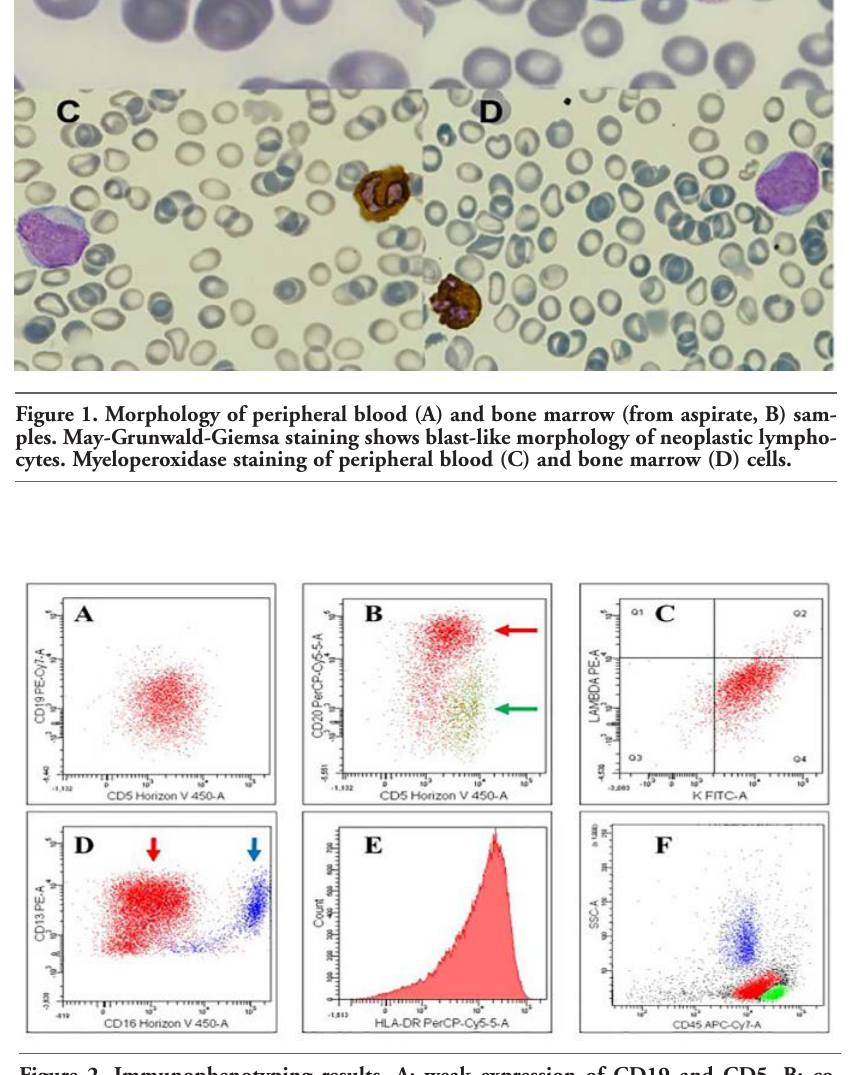
Figure 2. Immunophenotyping results. A: weak expression of CD19 and CD5. B: co- expression of CD20 and CD5 (red dots and red arrow); the green dots and the green arrow show the pattern of CD5 expression by the residual T-lymphocytes. C: restriction for sur- face immunoglobulin K light chains. D: pattern of CD13 expression of neoplastic lym- phocytes (red dots and red arrow) compared with neutrophils (blue dots and blue arrow). E: positivity of HLA-DR; F: CD45: back-gating; the neoplastic population shows differ- ent CD45 and SSC properties compared with residual normal